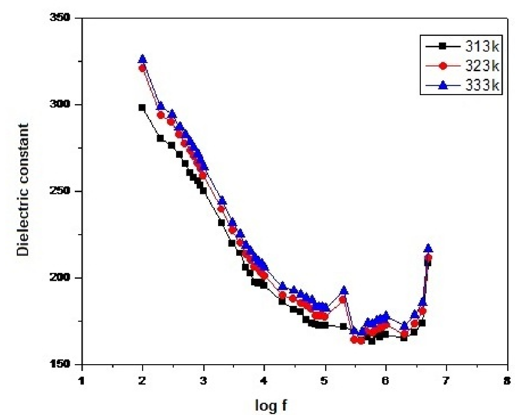
Figure 10. Dielectric constant vs log of frequency of MMTG